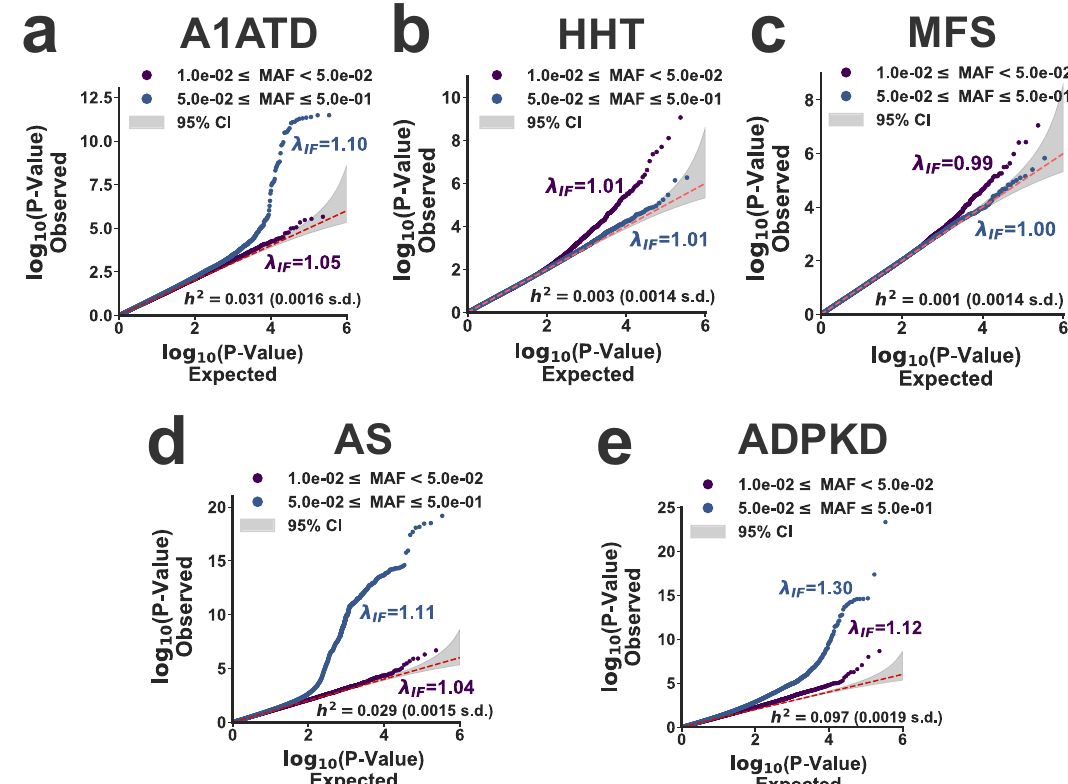
Fig. 4 Common variation associated with cryptic phenotype severity. a – e Each panel displays the observed versus expected P -value quantiles for the cryptic phenotype genome-wide association statistics, strati fi ed by allele frequency (purple: 0.01 ≤ AF < 0.05; blue 0.05 ≤ AF ≤ 0.50). Genomic in fl ation factors ( λ IF ) are provided in addition to the common variant heritability estimates ( h 2 ± std errors; estimated using the LDAK toolkit 76 , see the “ Methods ” section). The dashed red lines indicate the expected quantile – quantile relationship under the null model of no association between the variants and the phenotype. The shaded gray areas represent the 95% con fi dence interval for this expected relationship. a α -1-Antitrypsin de fi ciency (A1ATD; N = 294,133 independent subjects). b Hereditary hemorrhagic telangiectasia (HHT; N = 308,381 independent subjects). c Marfan syndrome (MFS; N =